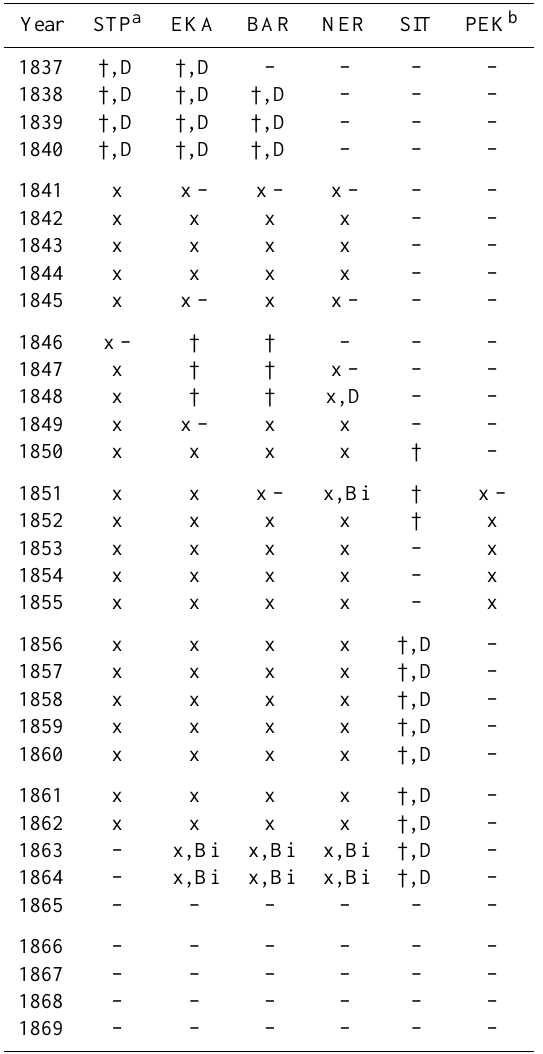
Table 2. Magnetic data availability of Russian observatory data 1837–1869 based on recordings of Gaussian type of unifilar ( D) and bifilar ( H)